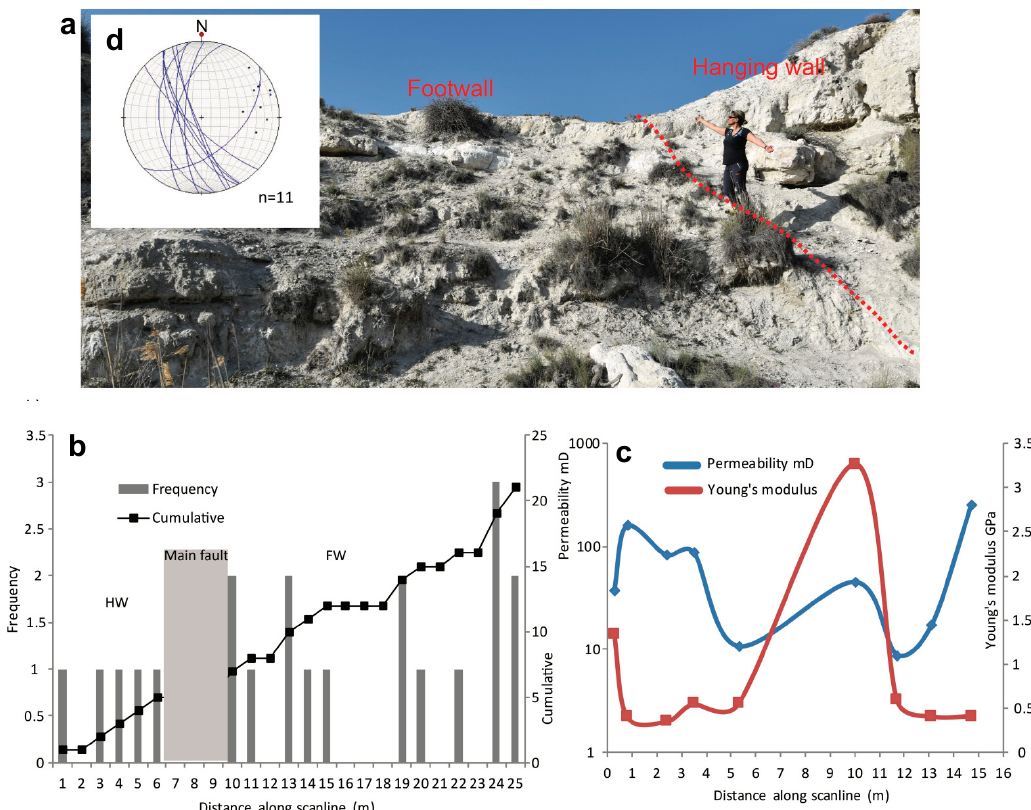
Figure 7. ( a ) Photo of the outcrop exposed in Barranco del Agua gully (west section) in the central segment of the Baza Fault. The person on the picture is standing along the fault between the hanging wall (behind her) and footwall. The origin of the scanline (0 point) was set up in the hanging wall of the fault and then continued into the footwall up to 25 m as far as the damage zone was accessible. ( b ) Frequency and cumulative distribution of fractures along the scanline. ( c ) Permeability and Young’s modulus measurements along the scanline. ( d ) Stereoplot of the fracture’s orientations. Table 3. XRD analysis of the samples from the central segment of the Baza Fault at the Barranco del Agua gully (west section). The distance corresponds to the distance from fault, which is also plotted on the x-axes of the plots in Figure 7.